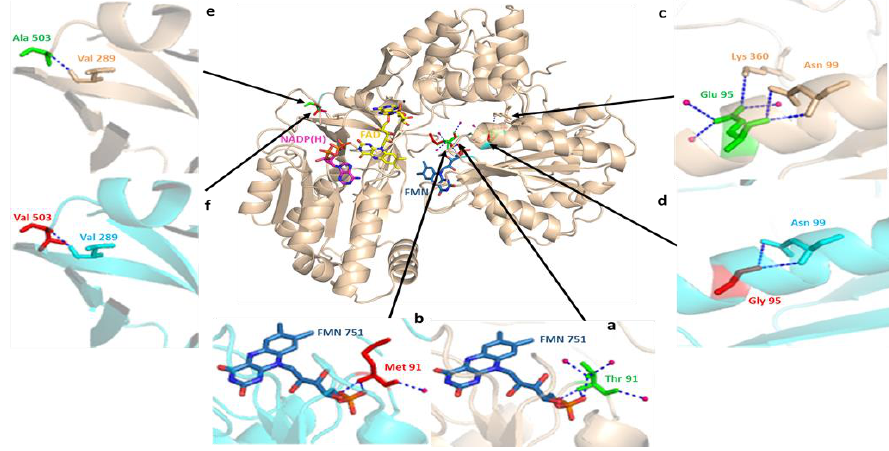
Figure 8. Three-dimensional structural alignment of wild-type human CYPOR (PDB: 3QE2) and mutant protein produced by in silico mutagenesis, showing missense mutations corresponding to the Pakistani population (wheat color) and wild-type (cyan color) peptide backbones. Cartoon structures of human CYPOR are depicted, as well as cofactors FMN (blue-gray) and FAD (yellow) and coenzyme NADP(H) (pink) in stick configuration. The interaction analysis of the wild-type and mutant residues strongly suggest that the two structures of human CYPOR are almost identical, except for the sites of missense SNPs. Partial views of crystal structures show a hydrogen bonding network involving water molecules (hot pink) and peptide backbones (blue dotted lines). ( a ) the wild-type Thr91 residue shows three hydrogen interactions each with the adjacent flavin mononucleotide (FMN) cofactor and water molecules; ( b ) the substitution of polar Thr91 with the nonpolar Met91 residue resulted in the loss of three hydrogen interactions, one with FMN and two with water molecules that were involved in its stabilization; ( c ) wild-type Glu95 directly interact with Asn99, Lys360 residues, and water molecules via hydrogen bonding; ( d ) a change in the hydrogen bonding network is observed due to the replacement of the negatively charged Glu95 with the nonpolar Gly95 residue; ( e ) hydrogen interaction between wild-type Ala503 and adjacent nonpolar Val289 residue; ( f ) apparently, the replacement of wild type Ala503 residue with Val503 does not affect the bonding interactions with the peptide